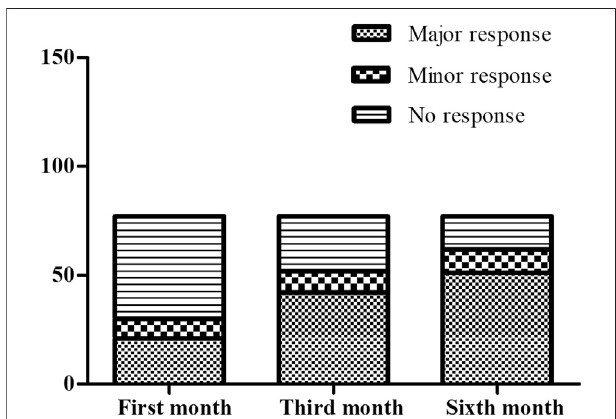
TABLE 1 | The patients ’ clinical characteristics ( n (cid:2) 77). Characteristics